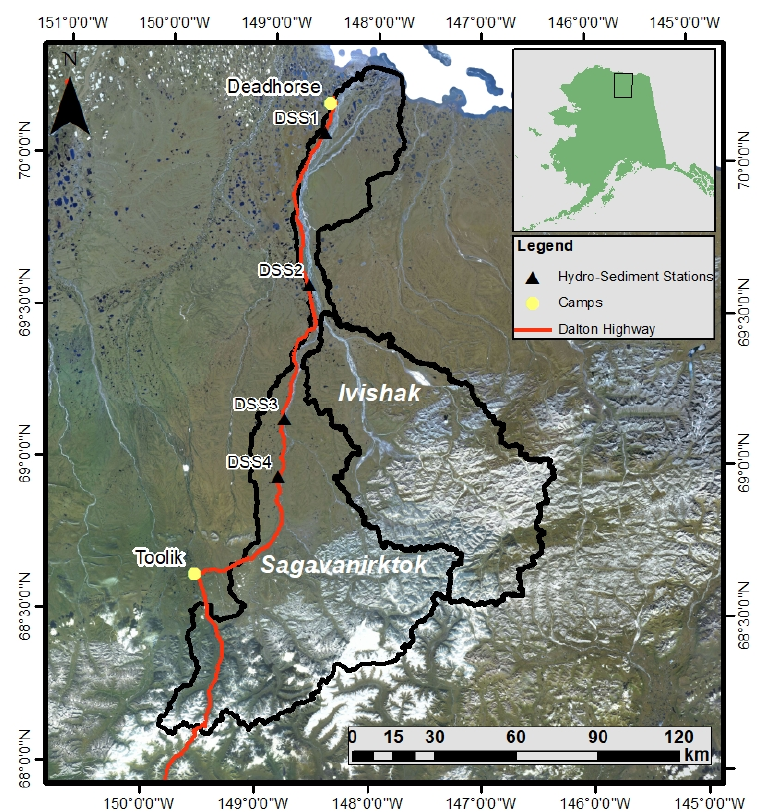
Figure 1. Sagavanirktok watershed area and hydrological stations along the river.